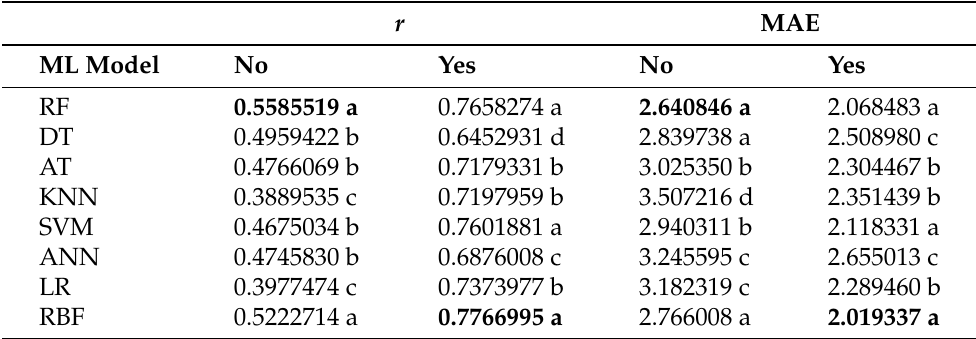
Table 2. Grouping of means by the Scott–Knott test for Pearson’s correlation coefficient (r) and mean absolute error (MAE) obtained with machine learning models using Diameter at breast height (DBH, cm) results without “No” and with “Yes” the species. The best values are highlighted in